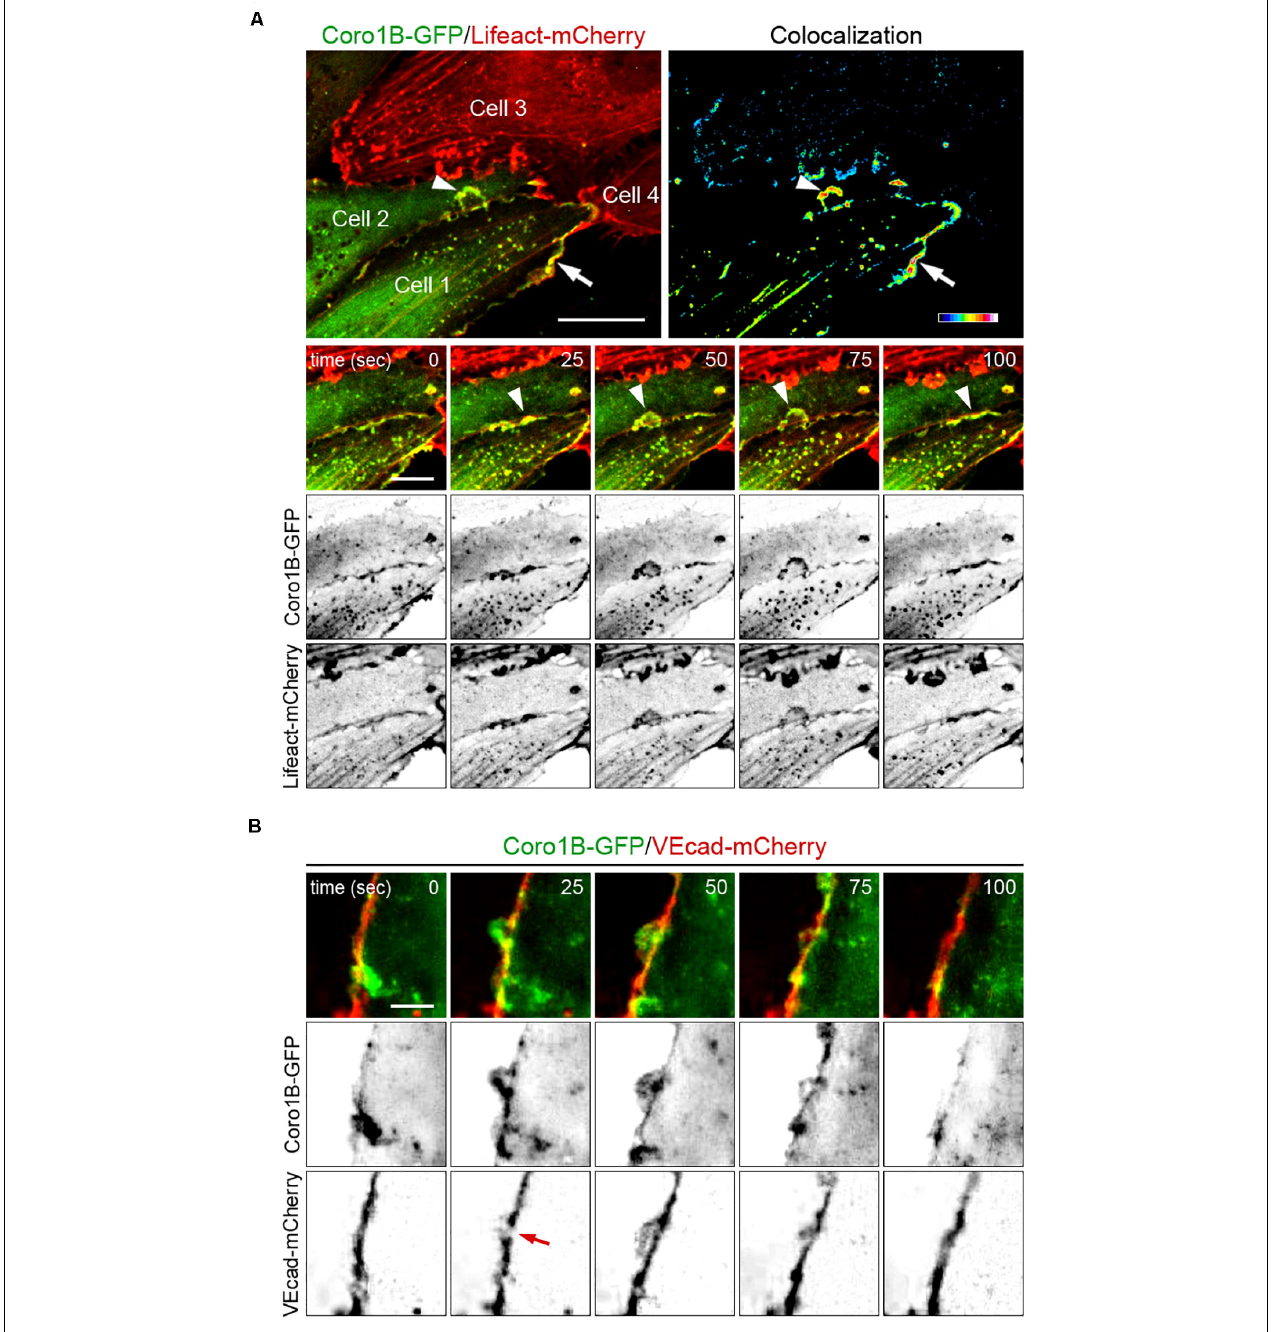
FIGURE 2 | Dynamics of Coro1B, F-actin and VEcad at cell–cell junctions. Still images from time-lapse recording of HUVECs expressing (A) Lifeact-mCherry (red) and Coro1B-GFP (green), and (B) VEcad-mCherry (red) and Coro1B-GFP (green). (A) Localization of Coro1B-GFP and Lifeact-mCherry at the leading edge of lamellipodia (arrow) and JAIL (arrowheads) at indicated time points. Upper panel, right: Colocalization of Coro1B-GFP and Lifeact-mCherry is displayed in a heat map. Scale bar = 10 µ m, color scale. Scale bar = 5 µ m. (B) Localization of Coro1B-GFP (green) and VEcad-mCherry (red) in double transfected HUVECs during JAIL formation in still images at indicated time points. Red arrow points to local reduction of VEcad. Scale bar = 5 µ